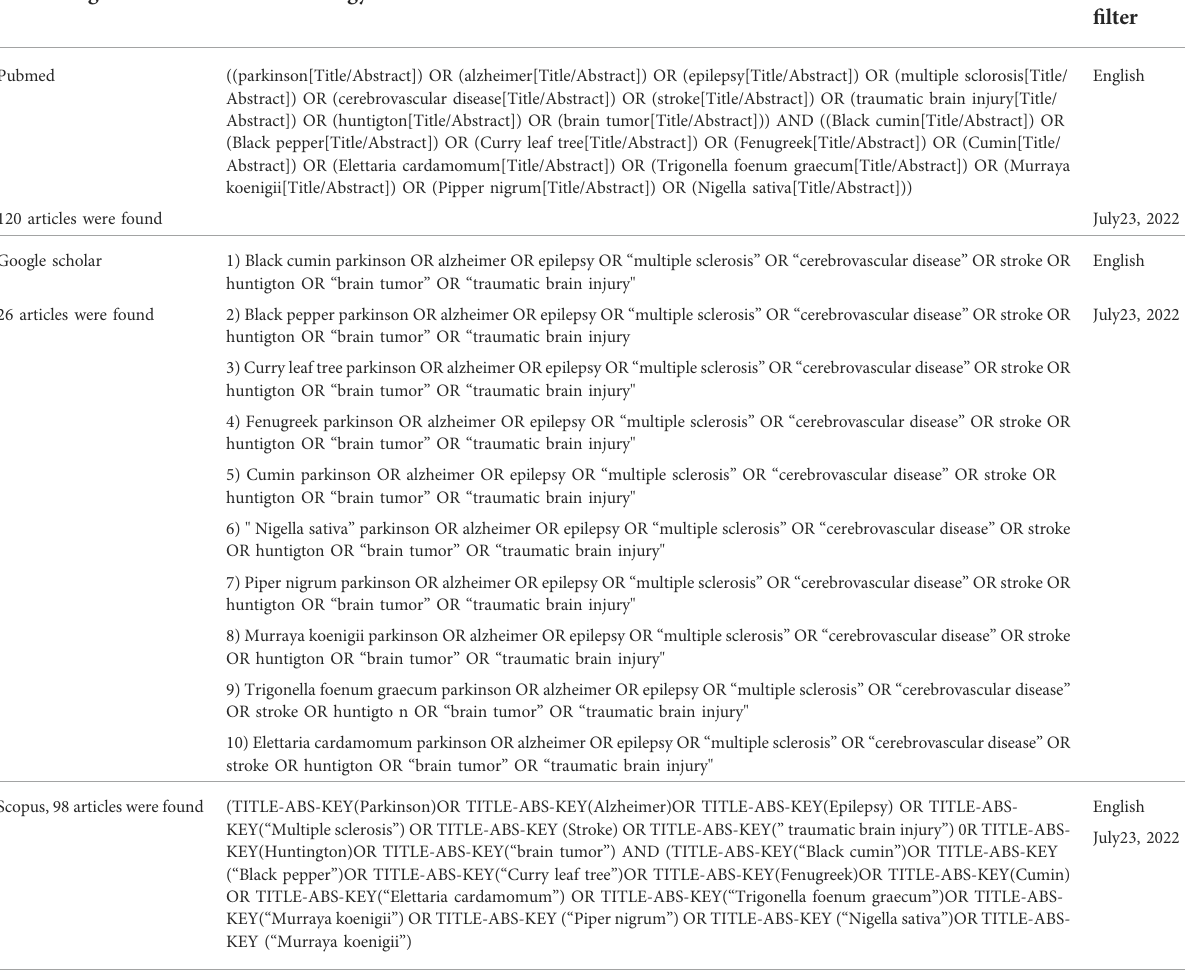
TABLE 1 A summary of the search strategy in PubMed, Scopus, and Google